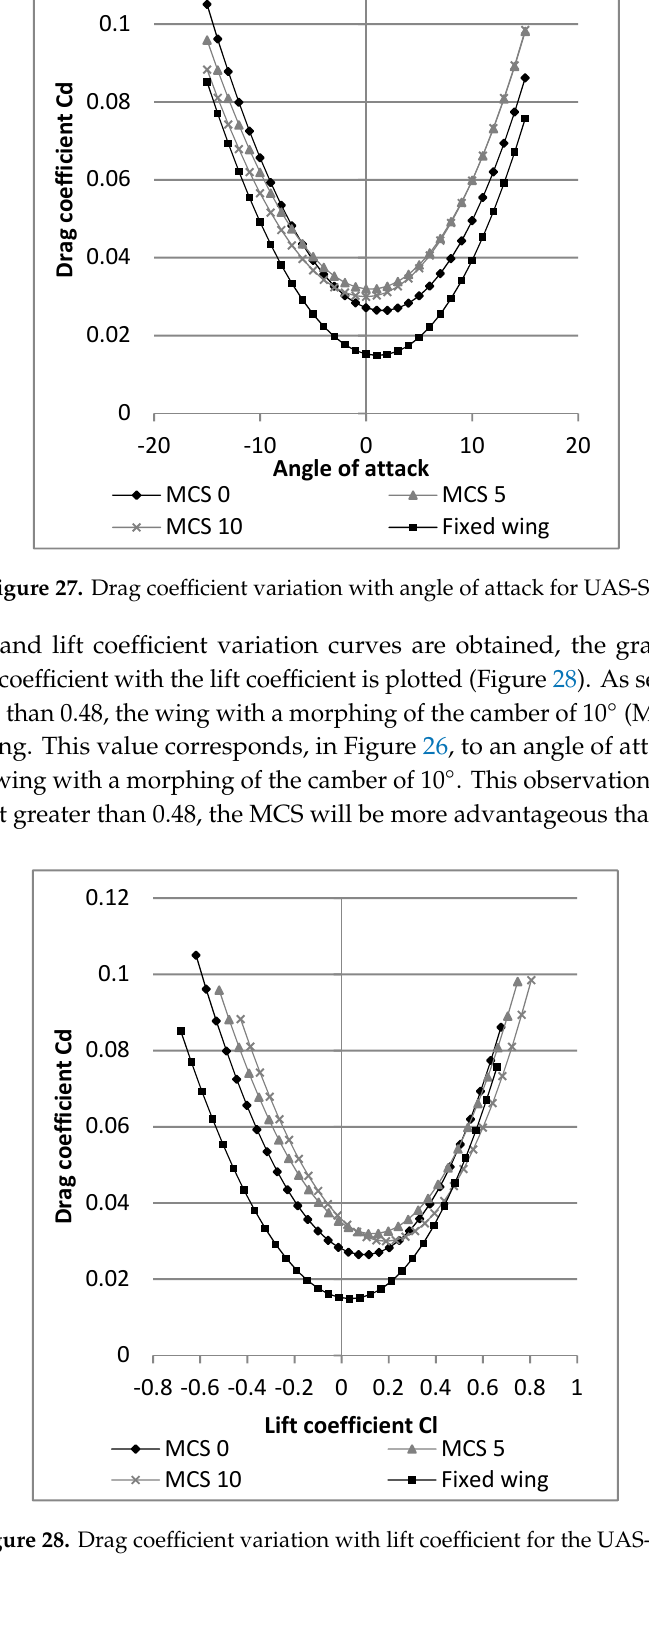
Figure 29 Drag coefficient variation with lift coefficient for UAS-S4 (zoom). 9. Conclusions In this article, a new system allowing the complete morphing of the camber, from the airfoil leading edge to its trailing edge, was presented from its design to its validation in a wind tunnel. The design of this system provides an easy-to-manufacture and lightweight MCS for the wing structure. The MCS will consequently not penalize the performance of the aircraft from its weight point of view. The method used to calculate the maximum displacements of the MLE and of the MTE makes it easy to size the slits without having to perform an FEA optimization process. In order to apply this method, the thickness of the material remaining at the slits must allow the rib to bend without causing its plastic deformation. To ensure this bending, anisotropic materials, such as